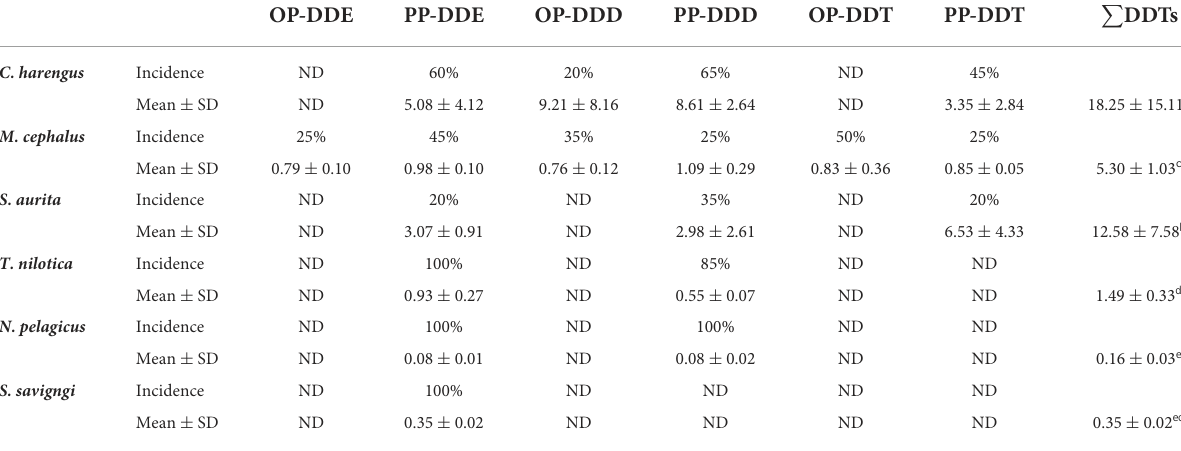
TABLE 3 Incidence and mean residual level (Mean ± SD) of Dichlorodiphenyltrichloroethane (DDT) in examined seafood species ( µ g.kg − 1 ) of wet weight ( n = 20 each).